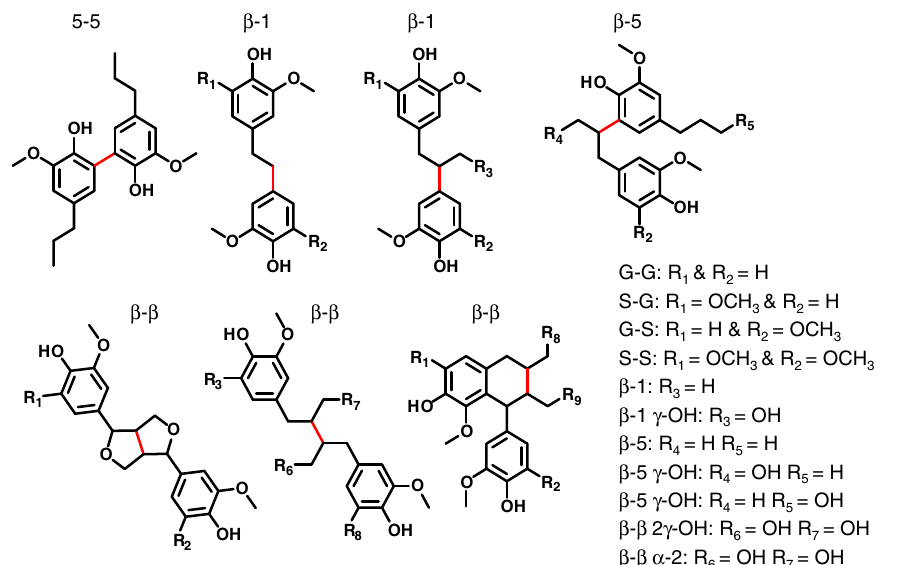
Fig. 4 Structures of observable dimers from fl ow-through RCF. Each dimer shown was identi fi ed in the RCF lignin oil using derivatization followed by GC-MS. Red lines indicate the carbon – carbon bond present between two monolignols, which corresponds to the naming convention. Each variation in functionalization (that was identi fi ed in the lignin oil) for each dimer is shown in the list on the